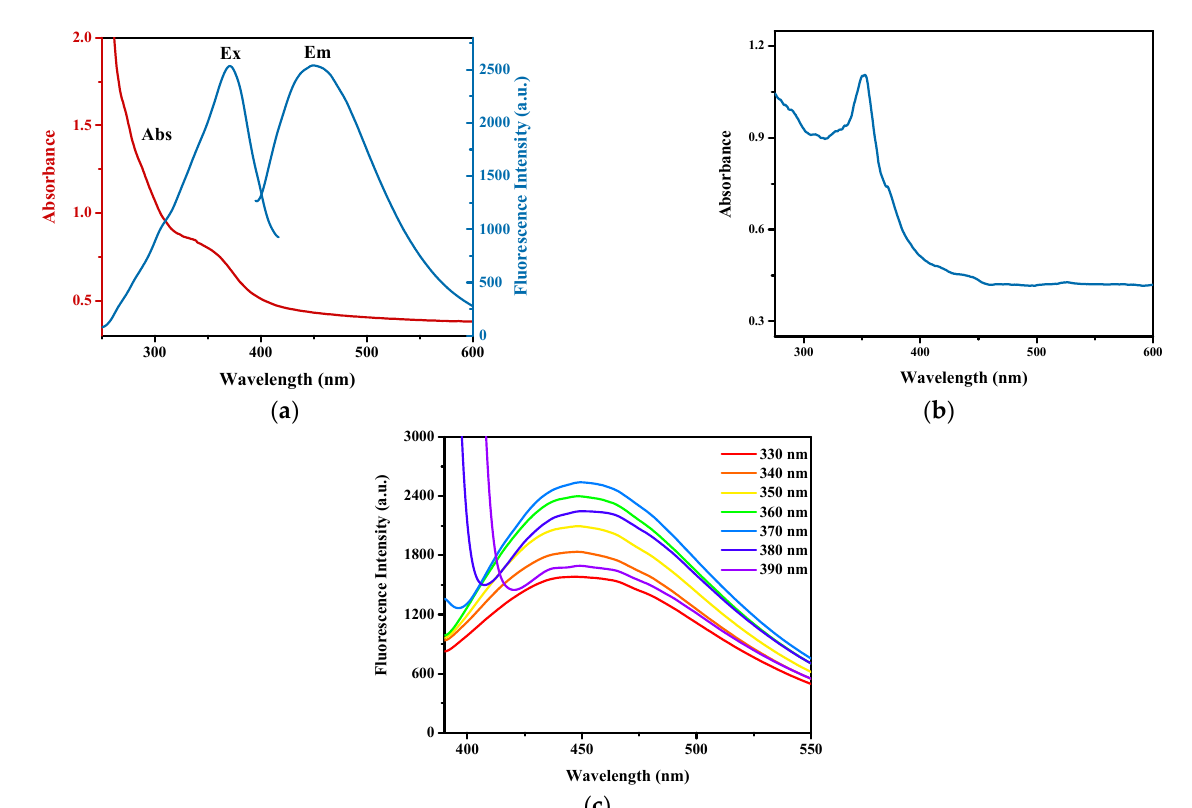
Figure 3. UV-Vis absorption and the optimal excitation and emission wavelengths ( a ), UV-Vis diffuse reflectance spectra ( b ), and excitation-dependent fluorescence spectra from 330 nm to 390 nm ( c ) of the PEI-CdS QD-embedded photonic crystal hydrogel.